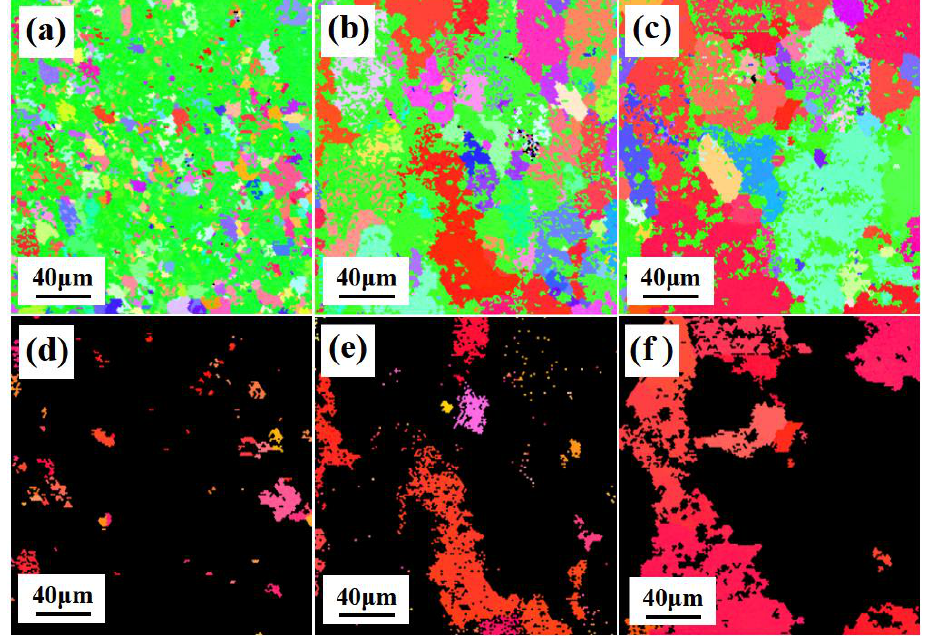
Figure 12. EBSD-derived IPF images of 80% cold-rolled samples after different annealing treatments: ( a ) 330 °C/0.5 h; ( b ) 420 °C/0.5 h; ( c ) 470 °C/0.5 h; ( d ) cube-orientated grains extracted from ( a ); ( e ) cube-orientated grains extracted from ( b ); ( f ) cube-orientated grains extracted from ( c ).